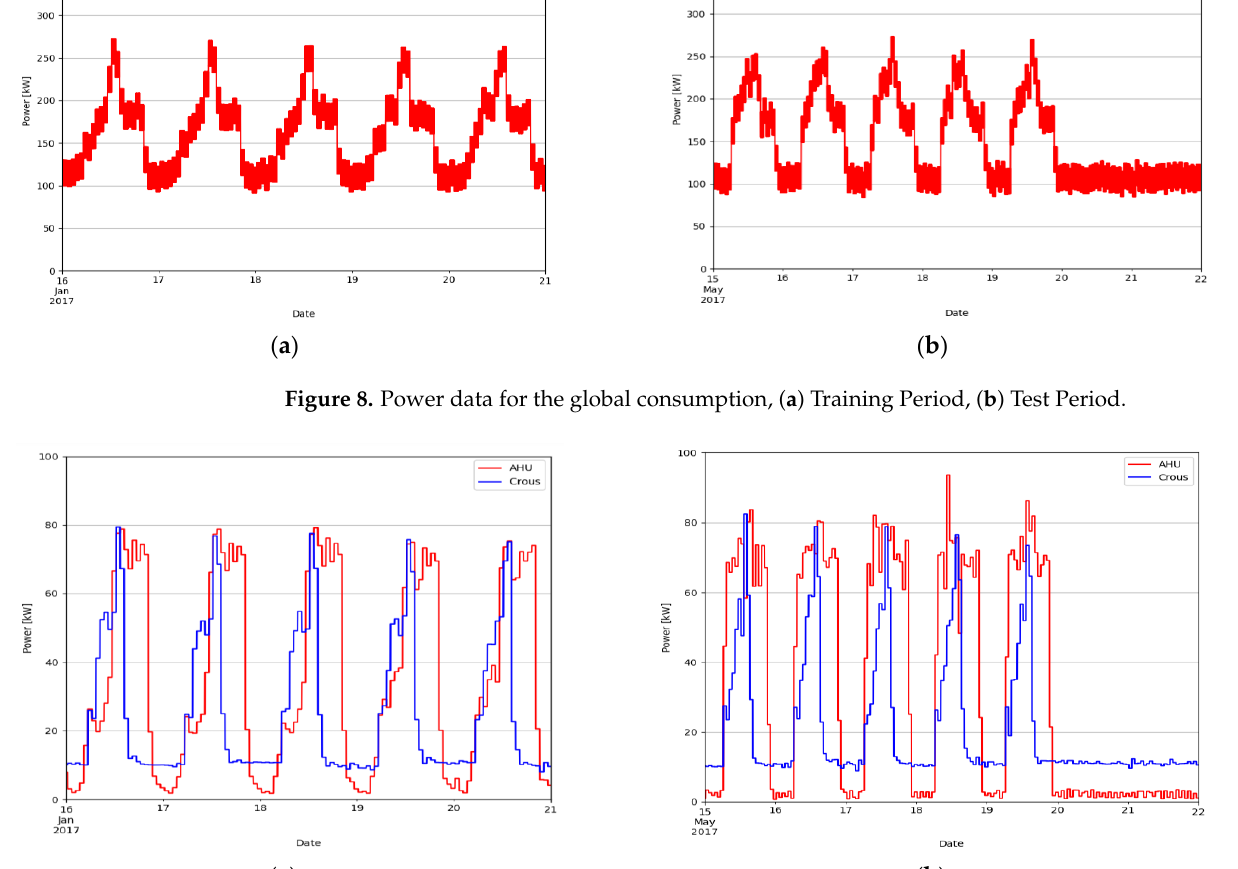
( a ) ( b ) Figure 10. Power data for the TD-GF, ASI and Ghost loads, ( a ) Training Period, ( b ) Test Period.